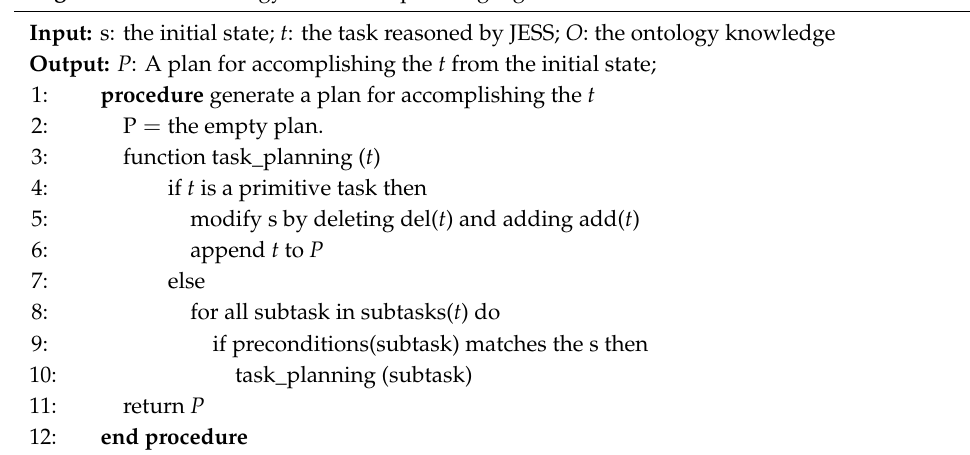
Algorithm 1 An ontology-based task planning algorithm